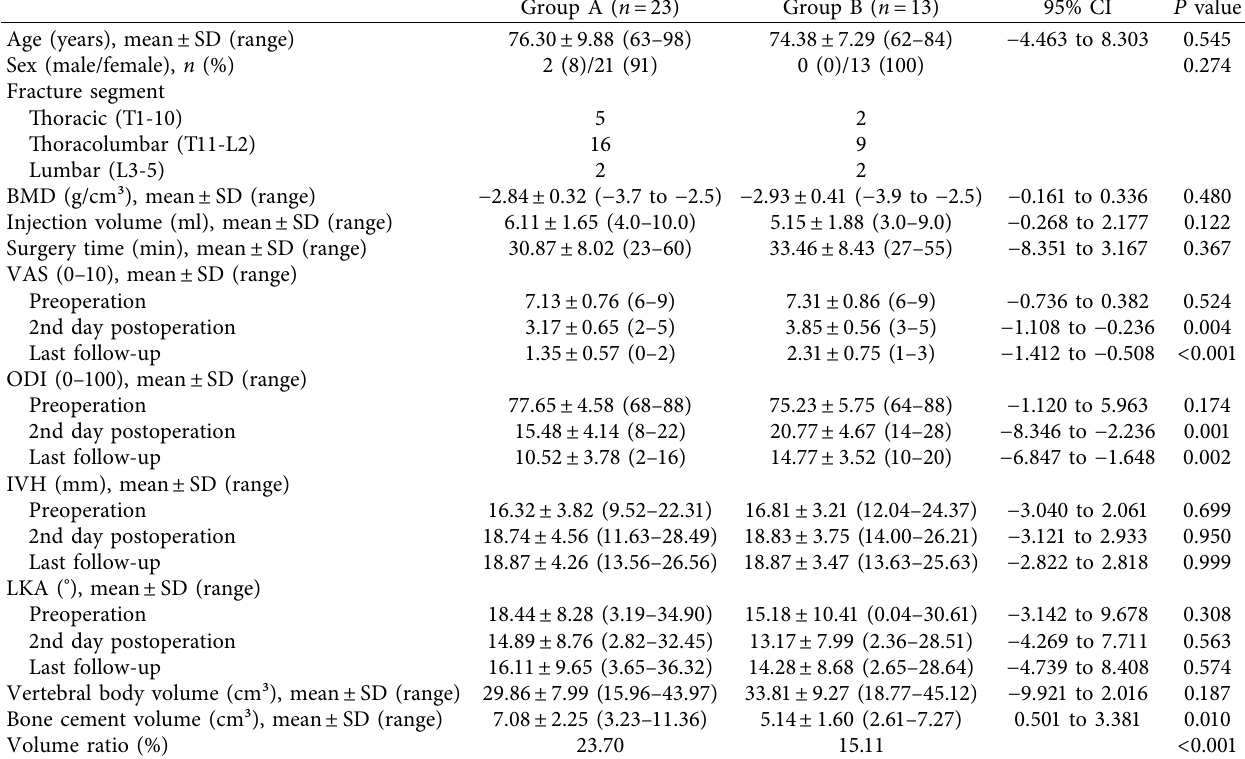
Table 1: Comparison between the groups.